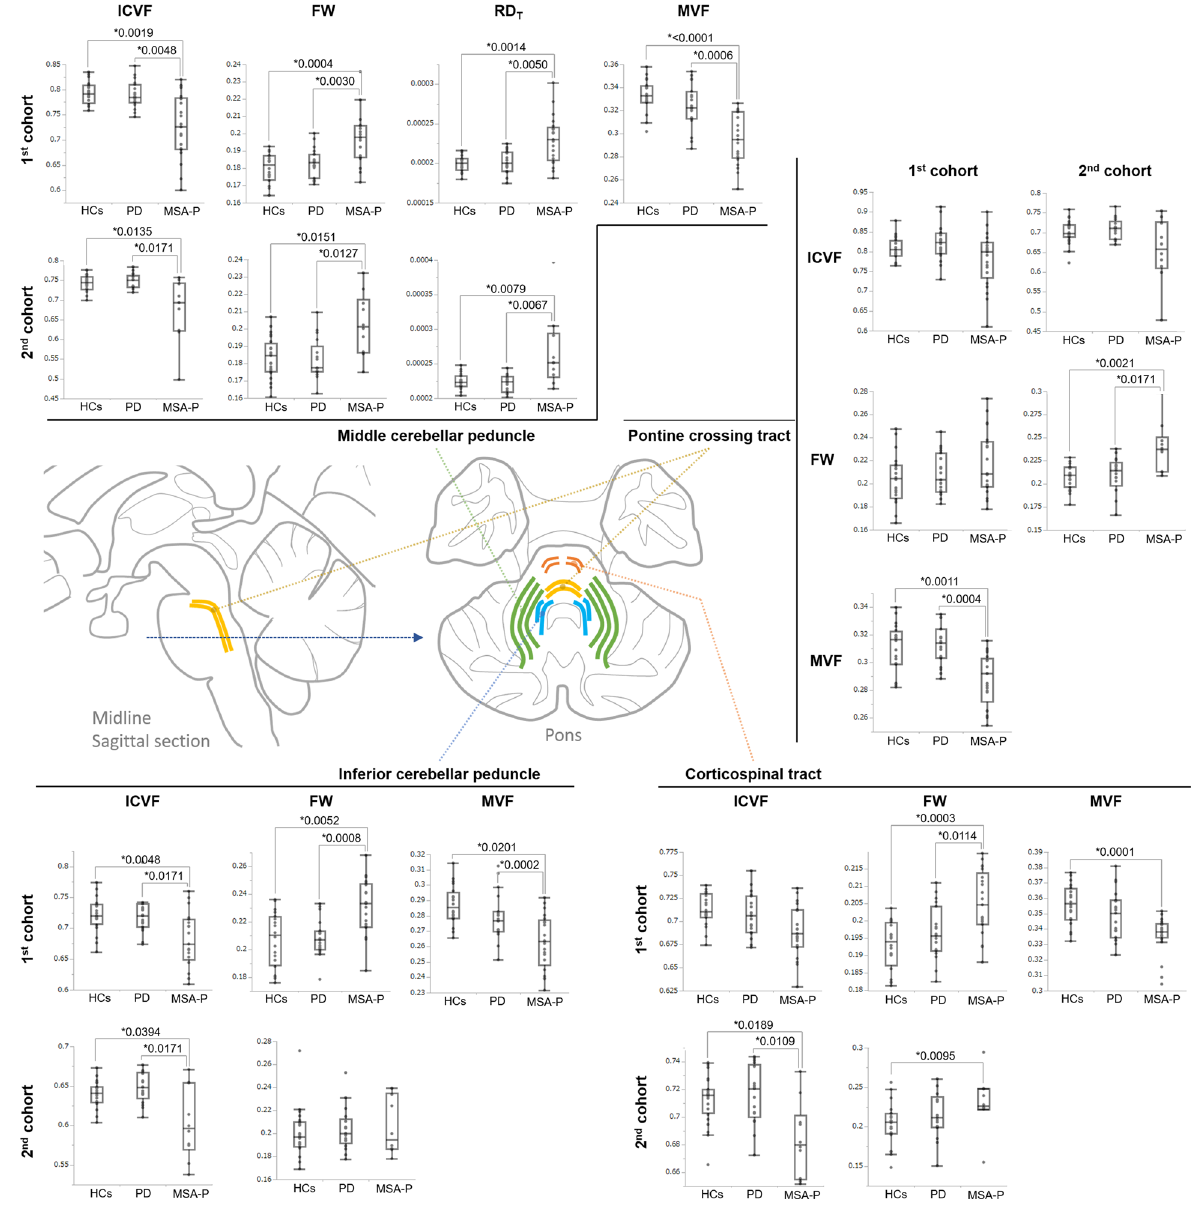
Fig. 2 Results of the white matter ROI analysis and schematic imaging of signi fi cant regions. Within the white matter, there were signi fi cantly lower ( P < 0.05, false discovery rate [FDR]-corrected) ICVF and MVF values, and signi fi cantly higher FW or RD T in the middle cerebellar peduncle (MCP; green line in schematic) and inferior cerebellar peduncle (ICP; light blue line) in MSA-P patients compared with HCs and PDs. The MVF values in the pontine crossing tract (yellow line) were signi fi cantly lower in MSA-P patients compared with HCs and PD, whereas FW in the corticospinal tract (CST; light red line) was signi fi cantly higher in MSA-P patients. In the second cohort of white matter, very similar results of fi rst cohort were observed in the four regions of MCP, ICP, PCT, and CST. The differences from the fi rst cohort were the absence of signi fi cant differences in FW in the ICP (although a non-signi fi cant trend remained), signi fi cantly higher FW in the PCT, and signi fi cantly lower ICVF in the CST of MSA-P patients compared with HCs and PD patients. In the boxplot, the center line represents the median, the box represents the third quartile, and the whiskers represent the maximum and minimum values. FW free water, ICVF intracellular volume fraction, MVF myelin volume fraction, pSN posterior part of SNc, RD T free water-corrected radial diffusivity, aSN anterior part of SNc, SNc substantia nigra pars